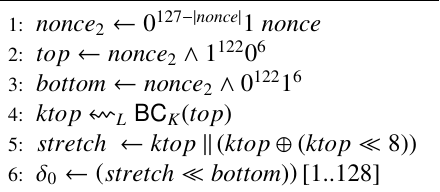
Algorithm 1 Initialization of δ 0 for OCB.